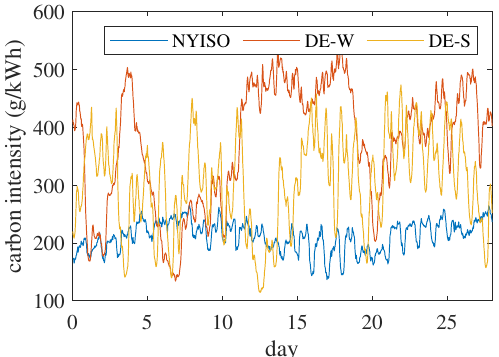
Figure 6. Carbon intensity for the three scenarios considered.